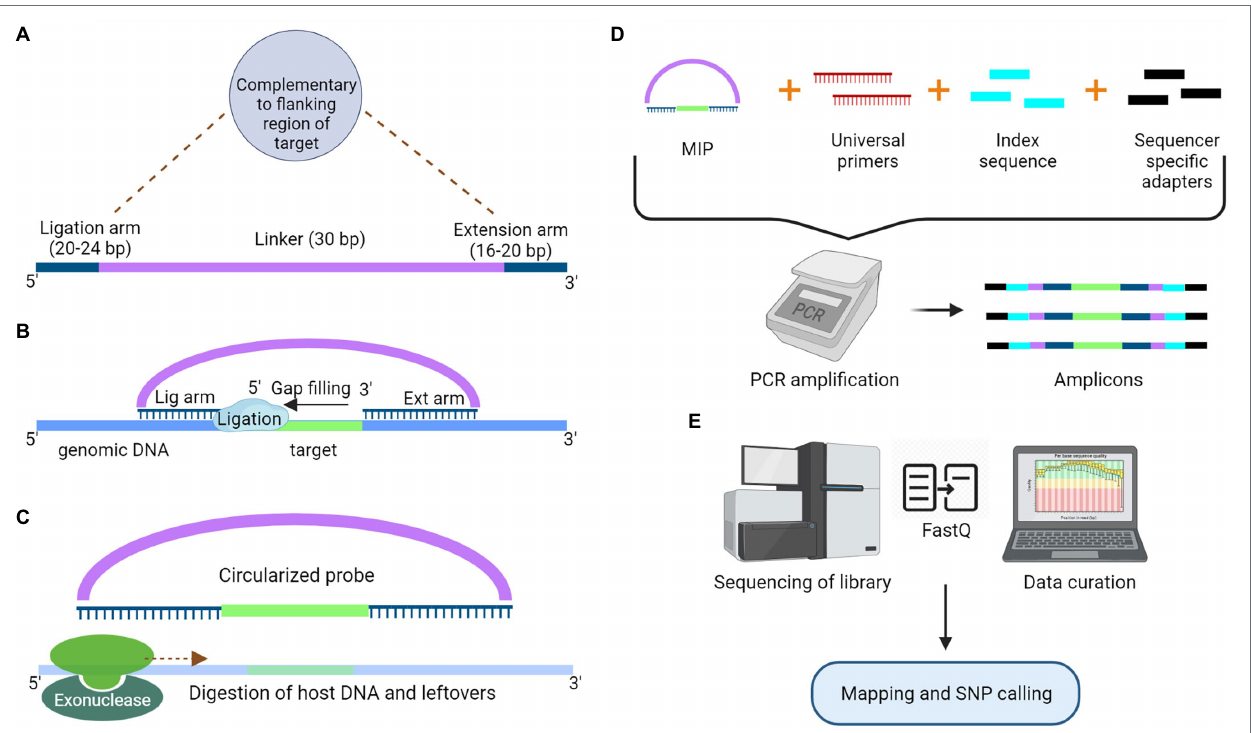
FIGURE 3 | Schematic representation of Molecular Inversion Probe to capture a specific target for sequencing. (A) Model structure of a molecular inversion probe (MIP) with a ligation and extension arm connected by a 30 bp linker. Both ligation and extension arms are designed to complement the target region. (B) These complementary arms at the end of linker pairs with the target region, which is followed by gap filling and ligation (Circular DNA molecule). (C) Digestion of exogenous host DNA and probes with the help of exonucleases. (D) Amplification of the captured segments using the universal primers complementary to the linker sequence of MIP along with sample-specific index sequences and sequencer-specific adapters. (E) Libraries will go through the sequencing followed by data